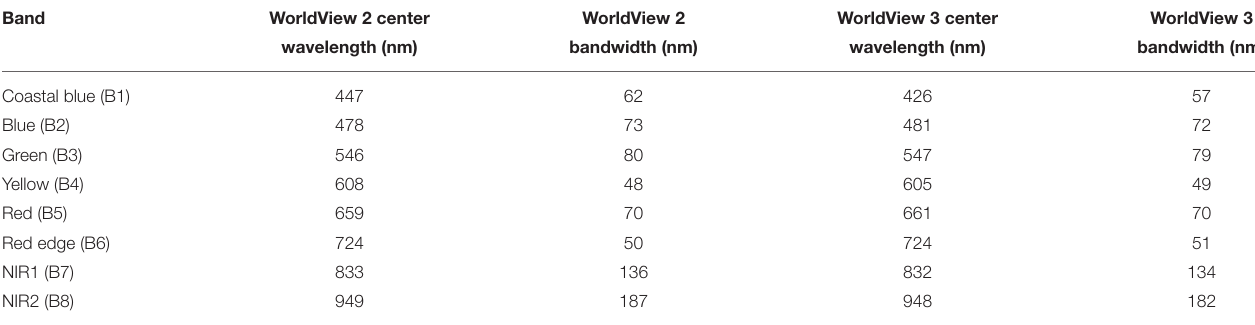
TABLE 1 | WorldView 2 and 3 band positions.